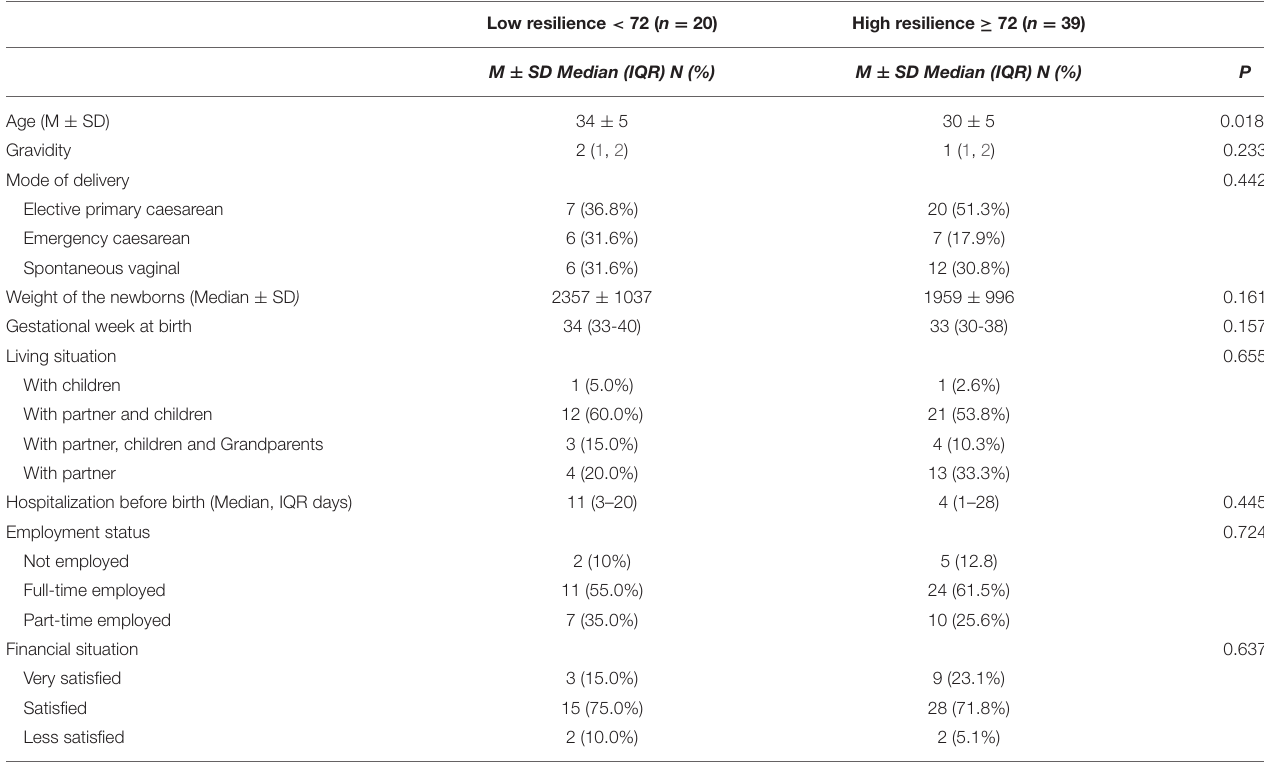
TABLE 1 | Clinical and demographic characteristics by level of resilience.